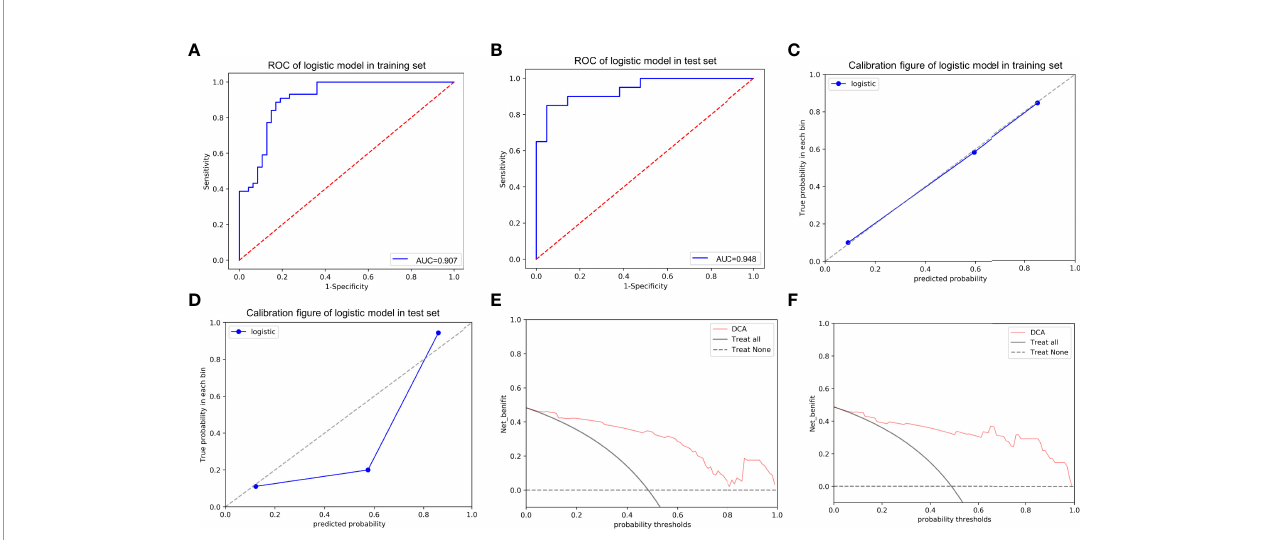
FIGURE 8 | The ROC curves of the nomogram in the training (A) and test (B) sets; the calibration curves of the nomogram for predicting early recurrence in the training (C) and test (D) sets, which demonstrated good agreement with the ideal curve. The prediction performance improved as the solid line approached the dotted line. The decision curve analysis (DCA) of the nomogram in the training (E) and test (F) sets. The net bene fi t of the nomogram was higher compared to the treat-all-patients scenario (gray line) and treat-no-patients scenario (horizontal dotted line).